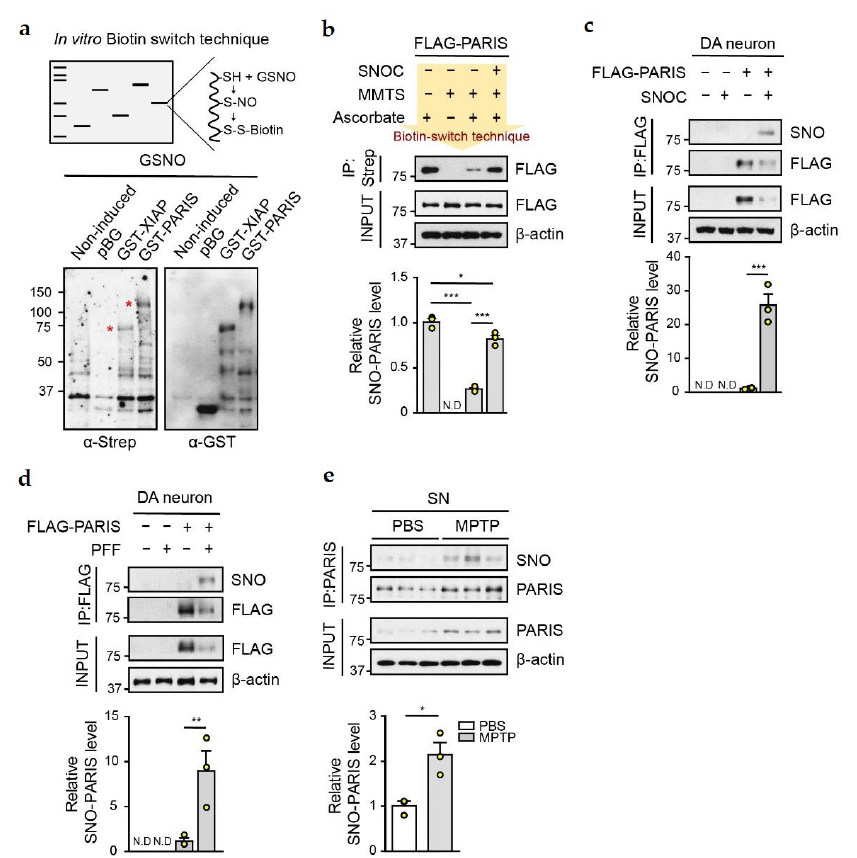
Figure 1. PARIS can be S-nitrosylated. ( a ) S-nitrosylation of PARIS using the in vitro biotin switch technique. Illustration depicting the process of biotin switch at the S-nitrosylation site (upper panel). Recombinant GST protein, GST-XIAP (S-nitrosylation positive control), and GST-PARIS were